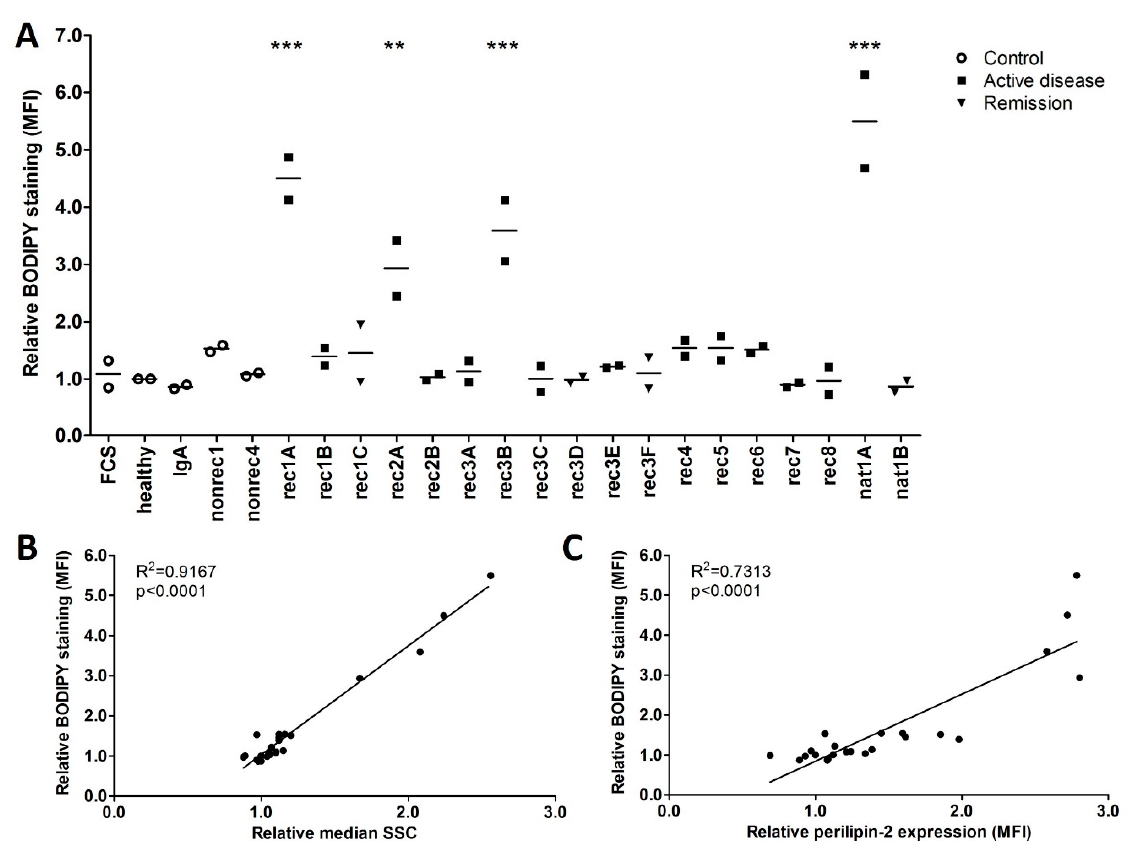
Figure 6. FSGS plasmas that increased BODIPY staining also increased granularity and perilipin-2 expression in hPod. ( A ) hPod differentiated in 6-well plates (Corning) were exposed in duplicate to active disease and remission FSGS plasmas, and to (disease) control plasmas. Prior to harvesting, cells were incubated with neutral lipid dye BODIPY 493/503 and flow cytometry was used to measure median fluorescence intensity (MFI). MFI of two replicate experiments and their means relative to healthy plasma are depicted. Circles represent controls, squares active disease FSGS plasmas, and triangles (partial) remission plasmas. ** p < 0.01, *** p < 0.001 compared to healthy plasma. ( B ) Correlation of BODIPY MFI from ( A ) with the relative median side scatter (SSC) from the same experiment, showing a significant and linear correlation. ( C ) Correlation of BODIPY MFI from ( A ) with the median perilipin-2 MFI from Figure 2B. FCS: fetal calf serum; healthy: pooled plasma from five healthy donors; IgA: patient with IgA nephropathy; nat: patient with FSGS in the native kidneys; nonrec: patient with non-recurrent FSGS; rec: patient with recurrent FSGS.